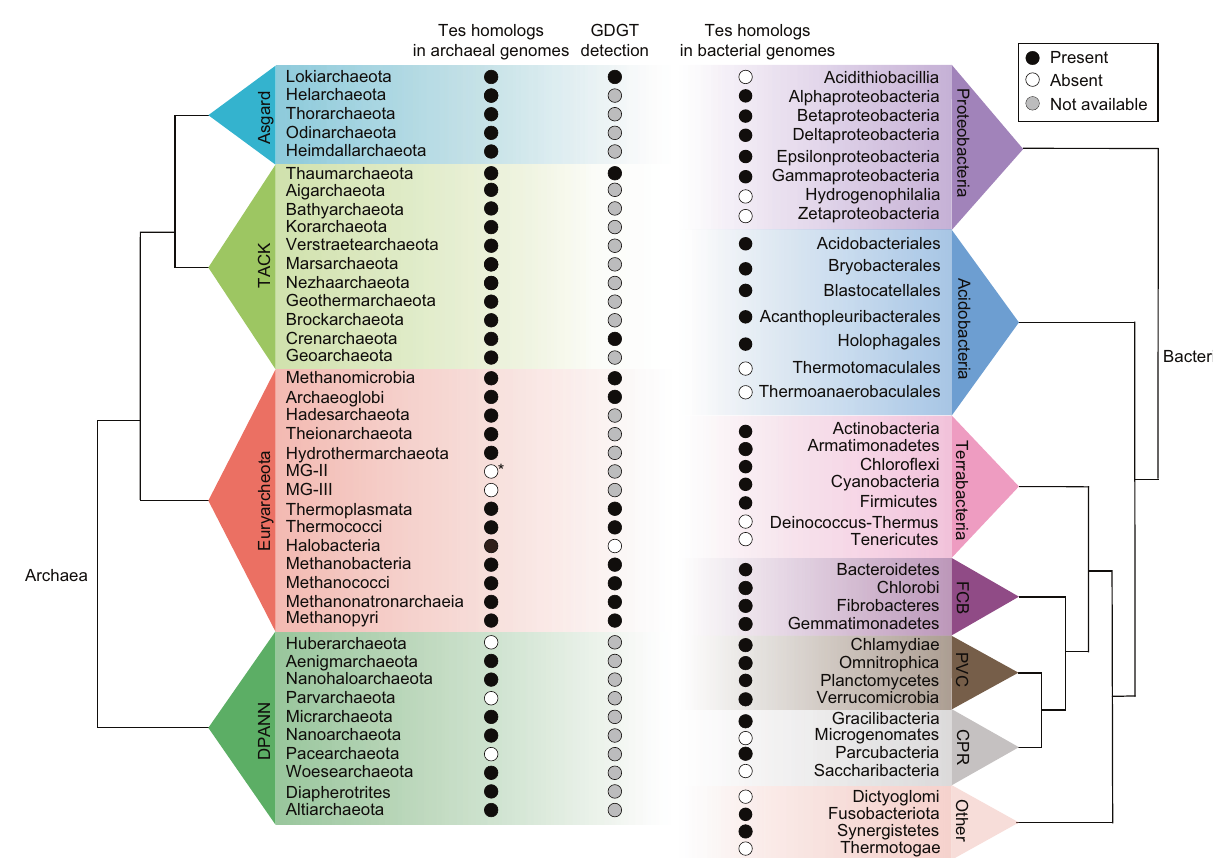
Fig. 4 Tes homologs are found in diverse archaeal and bacterial phyla. These data were generated through BLASTP searches of Tes homologs ( e - value < 1e − 50 , identity > 20%) in the NCBI database and searching published studies demonstrating GDGT production from pure cultures 3,5,9,10,36,69 – 71 . At least one strain or one genome in the phylum, class or order containing the Tes homolog and GDGTs (at least GDGT-0) is marked with a black circle. Otherwise, archaea or bacteria without any Tes homolog or GDGTs are marked with white circles. Uncultured archaeal strains or with cultured strains not yet tested for GDGT production, are marked with gray circles. Only one putative Tes homolog ( e -value = 6e − 53 , identity = 28%) was identi fi ed from 231 MG-II MAGs (*). Phylogenetic lineages of archaea and bacteria are modi fi ed from references 31,72,73 . Proteobacteria and acidobacteria are divided into class level and order level, respectively. Terrabacteria, FCB (Fibrobacteres-Chlorobi-Bacteroidetes), PVC (Planctomycetes-Verrucomicrobia-Chlamydiae) and CPR (Candidate Phyla Radiation) are bacterial superphyla 72,73 and only several phyla are shown in each group. Bacterial phyla that do not belong to these groups are assigned “ Other ” in the fi gure. Details and references are listed in Supplementary Table